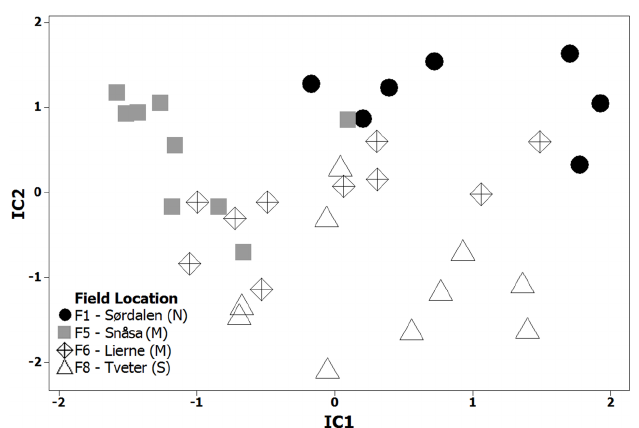
Fig. 1: Independent Component Analysis (ICA) in an untargeted approach based on a total of 817 non-annotated metabolite tags of berry samples from individual plants harvested at field trial locations F1 (Sørdalen) (n=7), F5 (Snåsa) (n=9), and F6 (Lierne) and F8 (Tveter) (both n=10) in 2009. N = Northern, M = Mid, and S = Southern